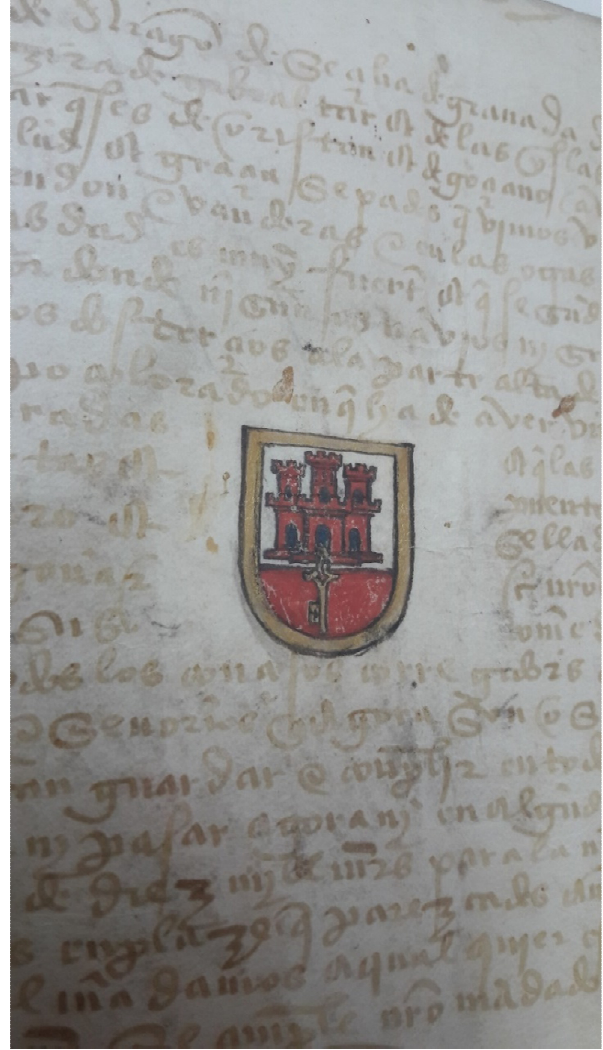
Figure 15. The coat of arms granted by the Catholic Monarchs to Gibraltar in 1502 [author’s photo- graph, © Archivo Municipal de San Roque].